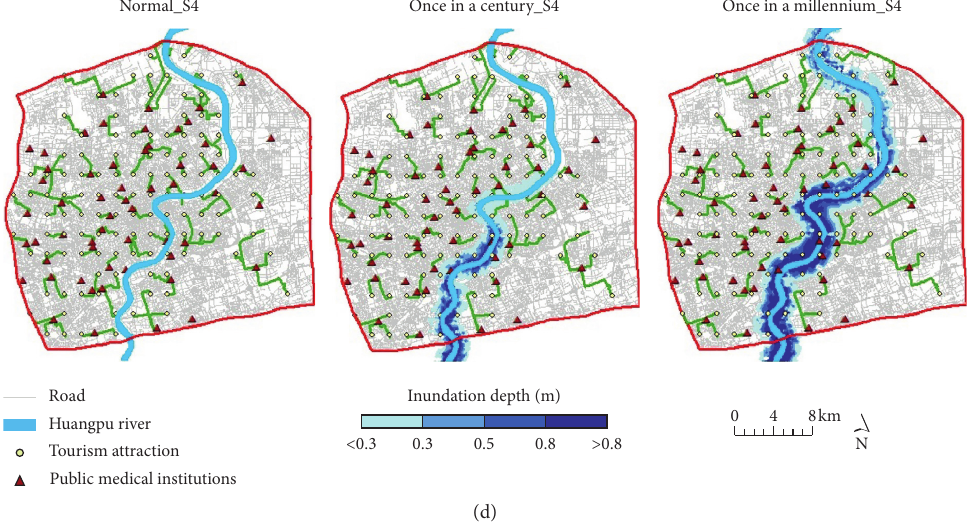
Figure 4: Closest facility analysis for public medical institutions to tourism attractions under normal conditions and flood scenarios in